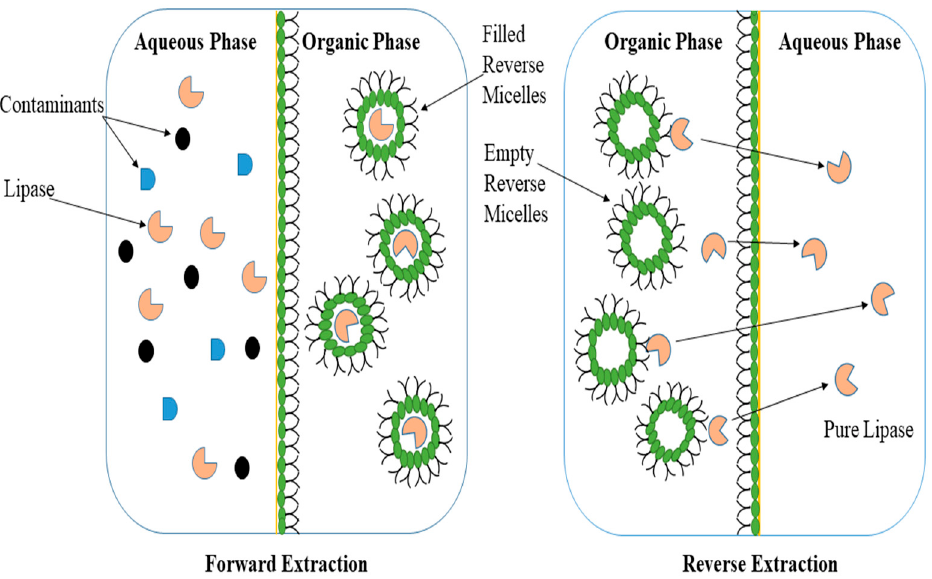
Figure 2. A schematic diagram of the two-step extraction in/with micellar systems.